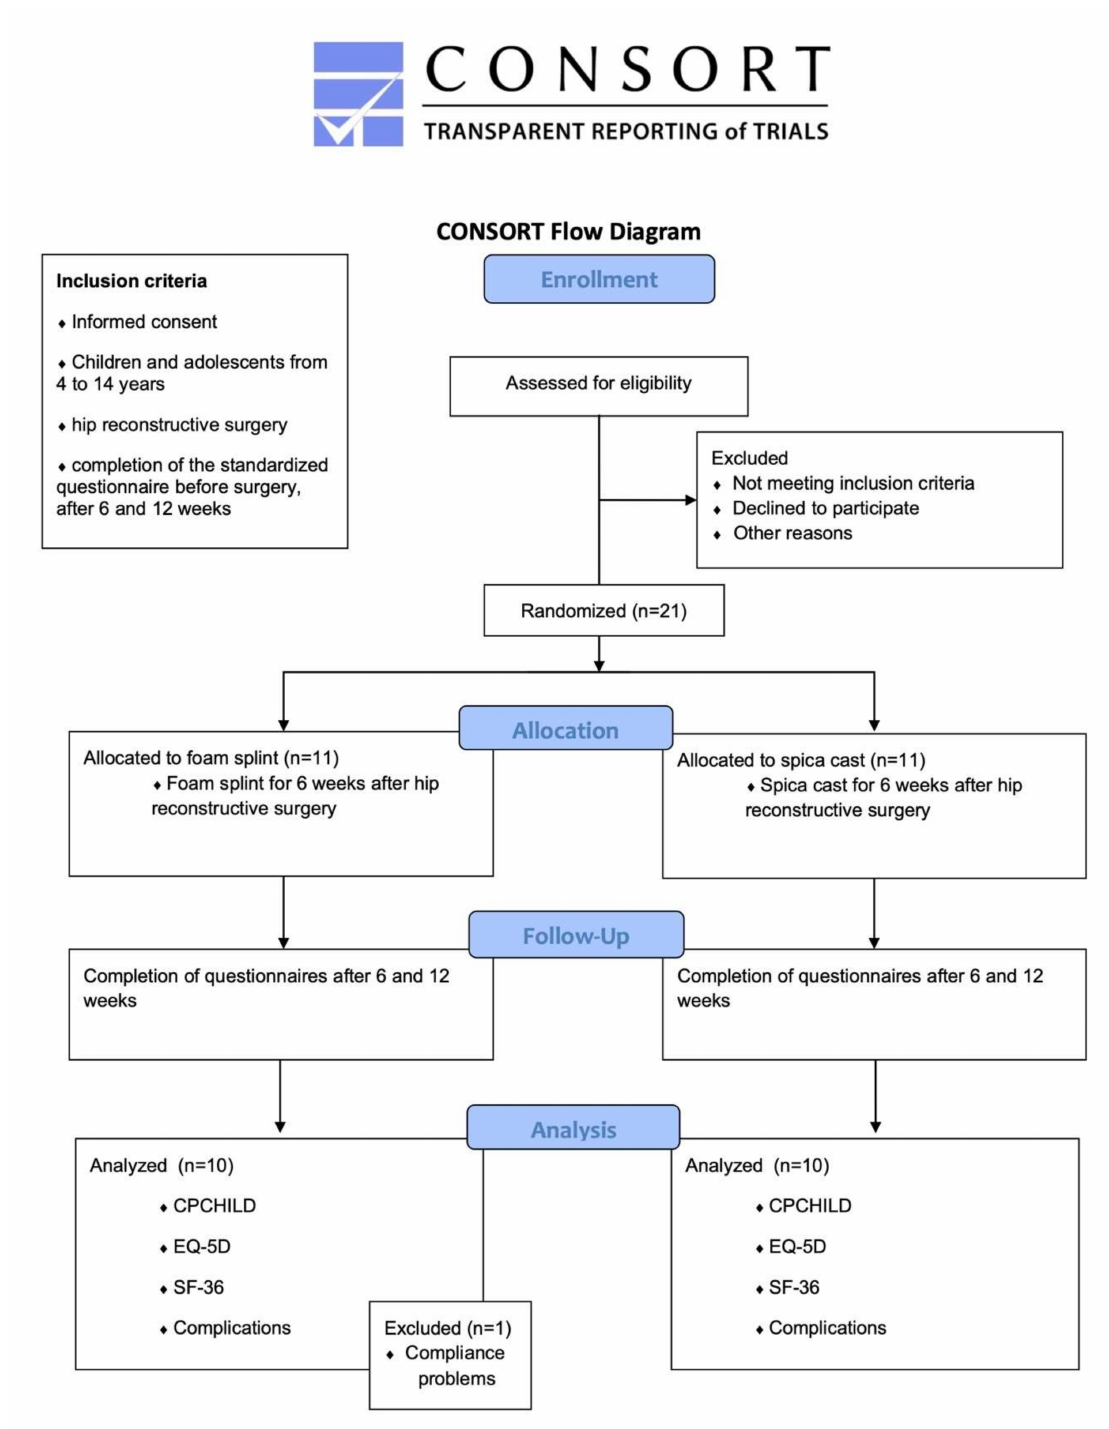
Figure 1. The algorithm of the trial; CONSORT diagram adapted from